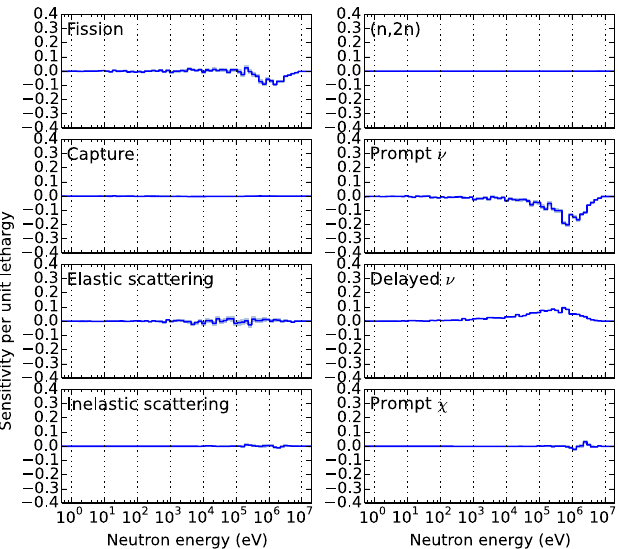
Fig. 6. 239 Pu sensitivity pro fi le for the critical core ( a =20).